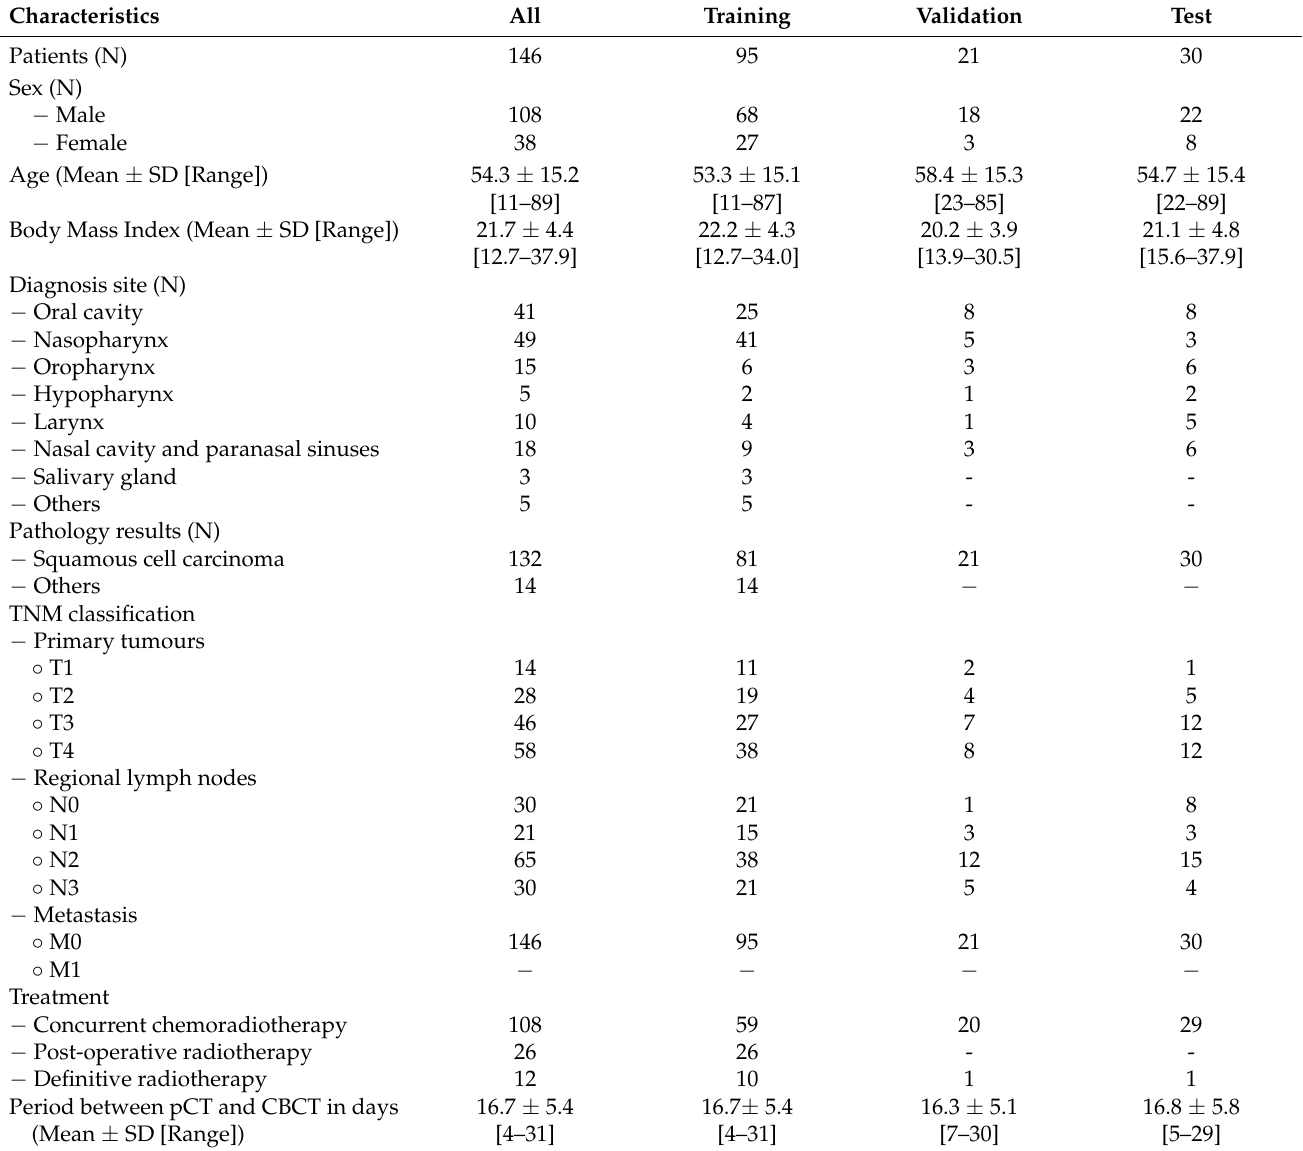
Table 1. Patient characteristics for the training, validation, and test